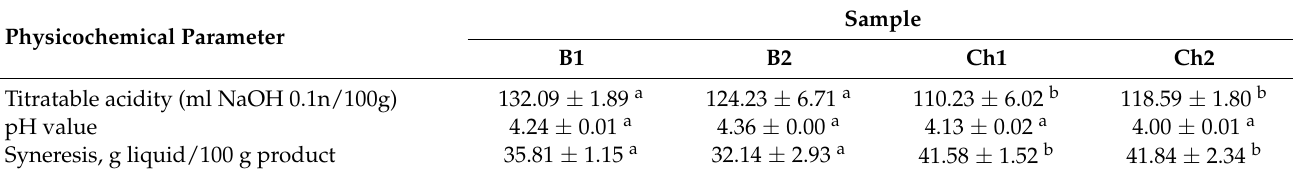
Table 4. Physicochemical characteristics of fermented vegetable